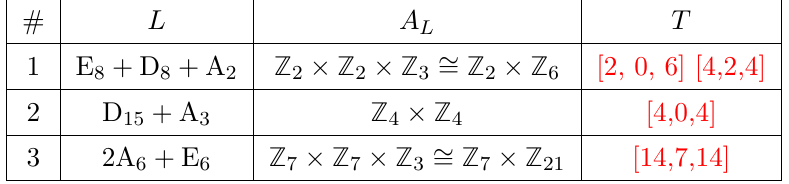
Table 4. Examples of forbidden L when d =